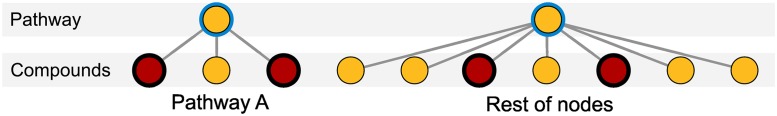
Toy example of an over-representation analysis of a hypothetical “pathway A” containing 3 metabolites out of a total of 10.The list to be enriched contains 4 metabolites, showing 2 hits in the pathway. The corresponding (Fisher’s exact test) over-representation can be understood as a diffusion process on the depicted network followed by a null model. The temperature of pathway A is always coincident with the number of hits in the pathway, implying that its null distribution is the hypergeometric distribution, to which a one-tailed temperature comparison is made.